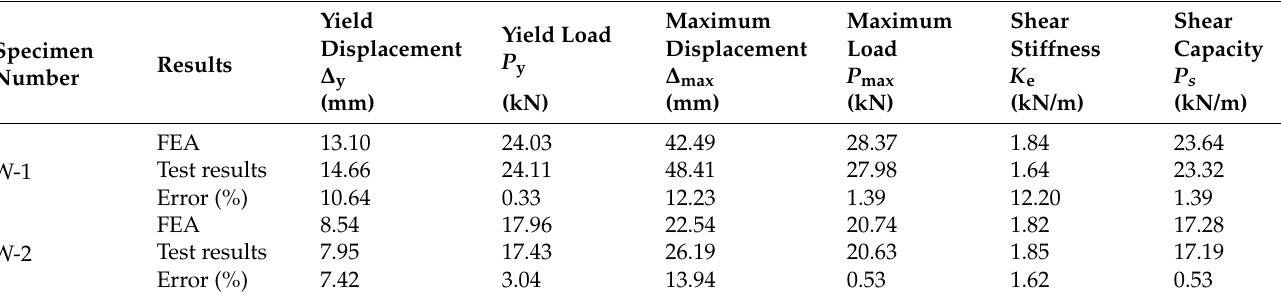
Table 10. Comparison of eigenvalues for FEA and test